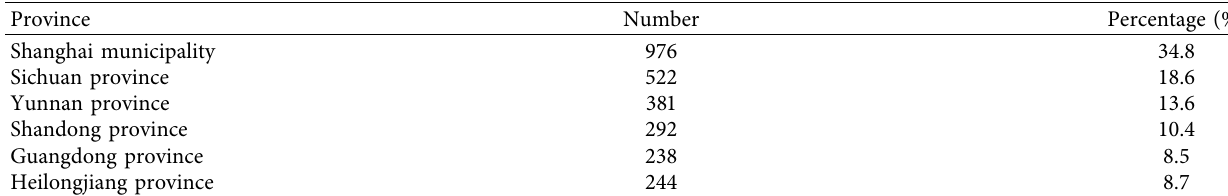
Table 2: Distribution of accident provinces.